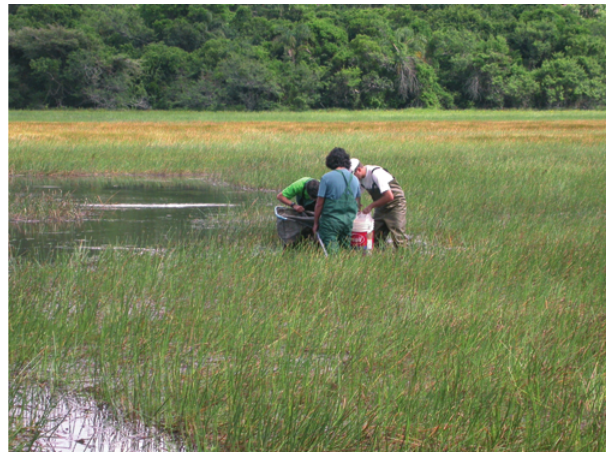
Fig. 6. Typical habitat of Brachyhypopomus draco ; marsh- land in the Parque Estadual de Itapuã, Rio Grande do Sul,